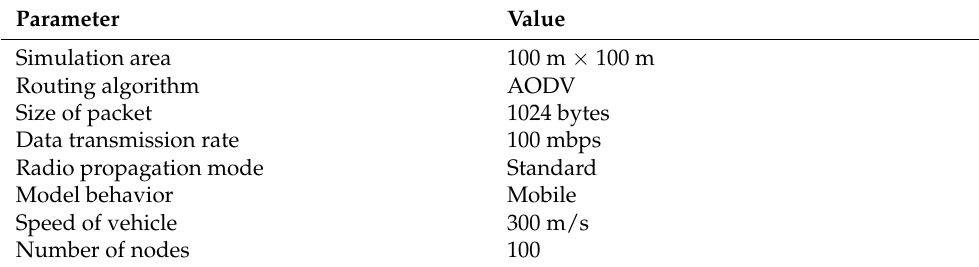
Table 1. Simulation